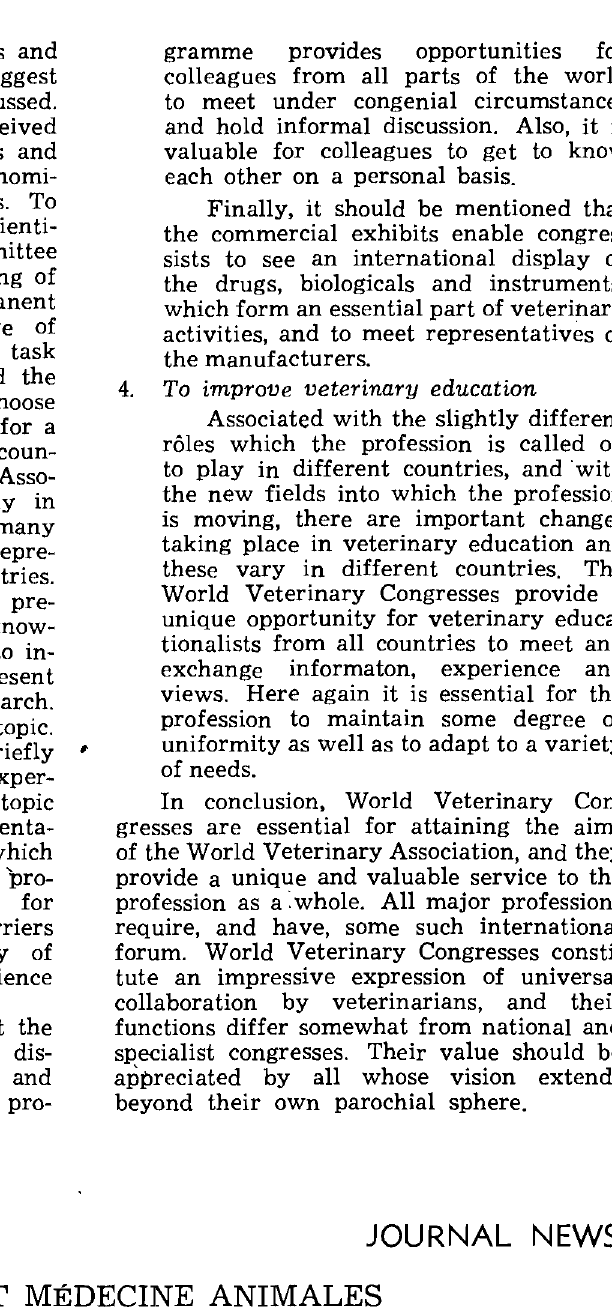
Hierdie tydskrif, uitgegee deur die ,Expansion Scientifique', Rue St. Benoit 15, Paris (6°), Frankryk, verbind suiwere wetenskap en praktyk in die veeartsenykunde oor 'n wye gebied. Die referate oor omgewingsbesoedeling en toksiese residue gelewer tydens die sittings insake menslike en dierlike patologie, gehou te Parys op 4 en 5 Oktober 1972, sal ook in die tydskrif opgeneem word. Abonnement beloop 42F per jaar, betaalbaar per bankwissel aan die